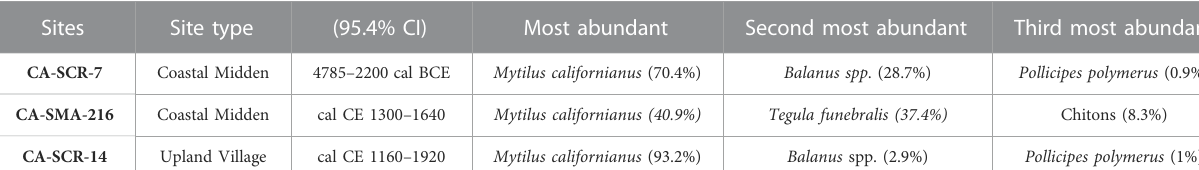
TABLE 3 Shell fi sh data from the Año Nuevo and Wilder Ranch study areas outlining most abundant shell fi sh taxa by weight.